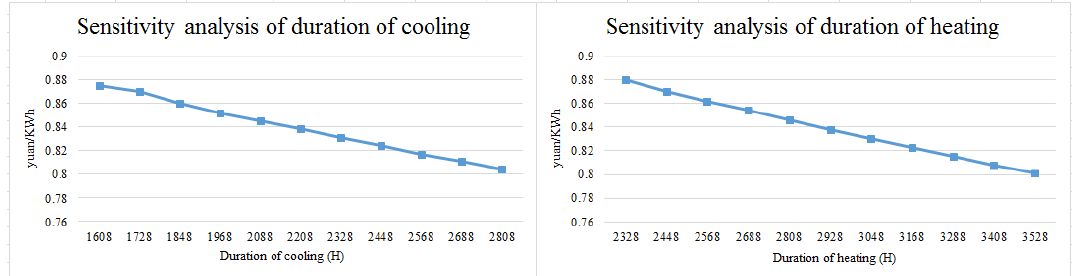
Figure 4. Diagram of sensitivity analysis.